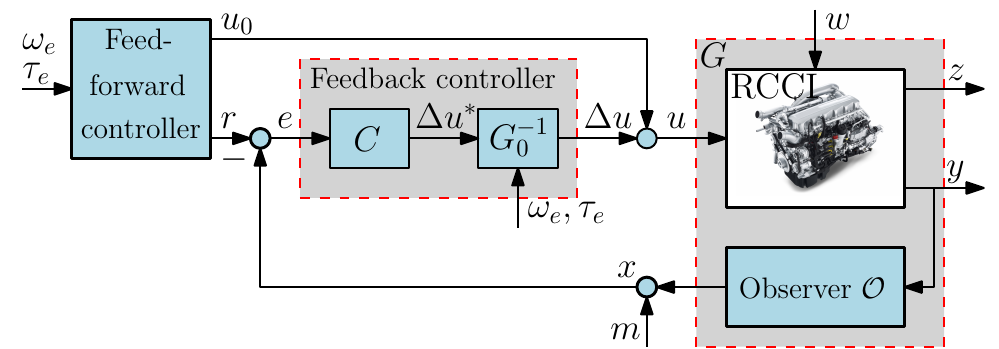
Figure 3. Scheme of the RCCI engine with the proposed control system architecture (adapted from